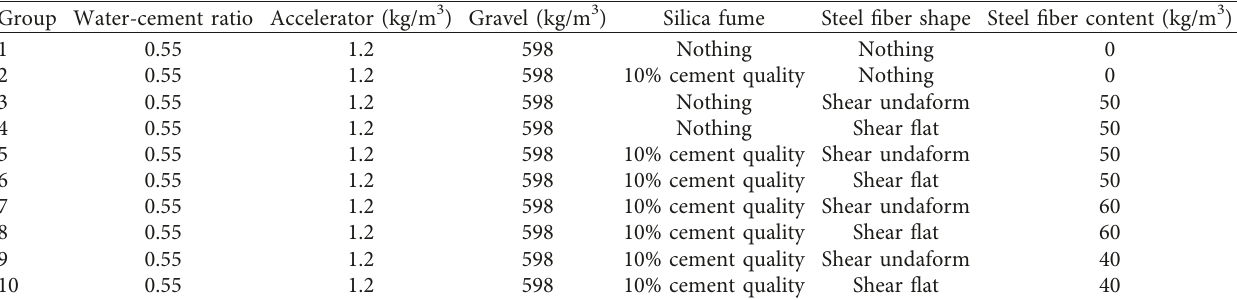
Table 3: Mix proportion of wet shotcrete.